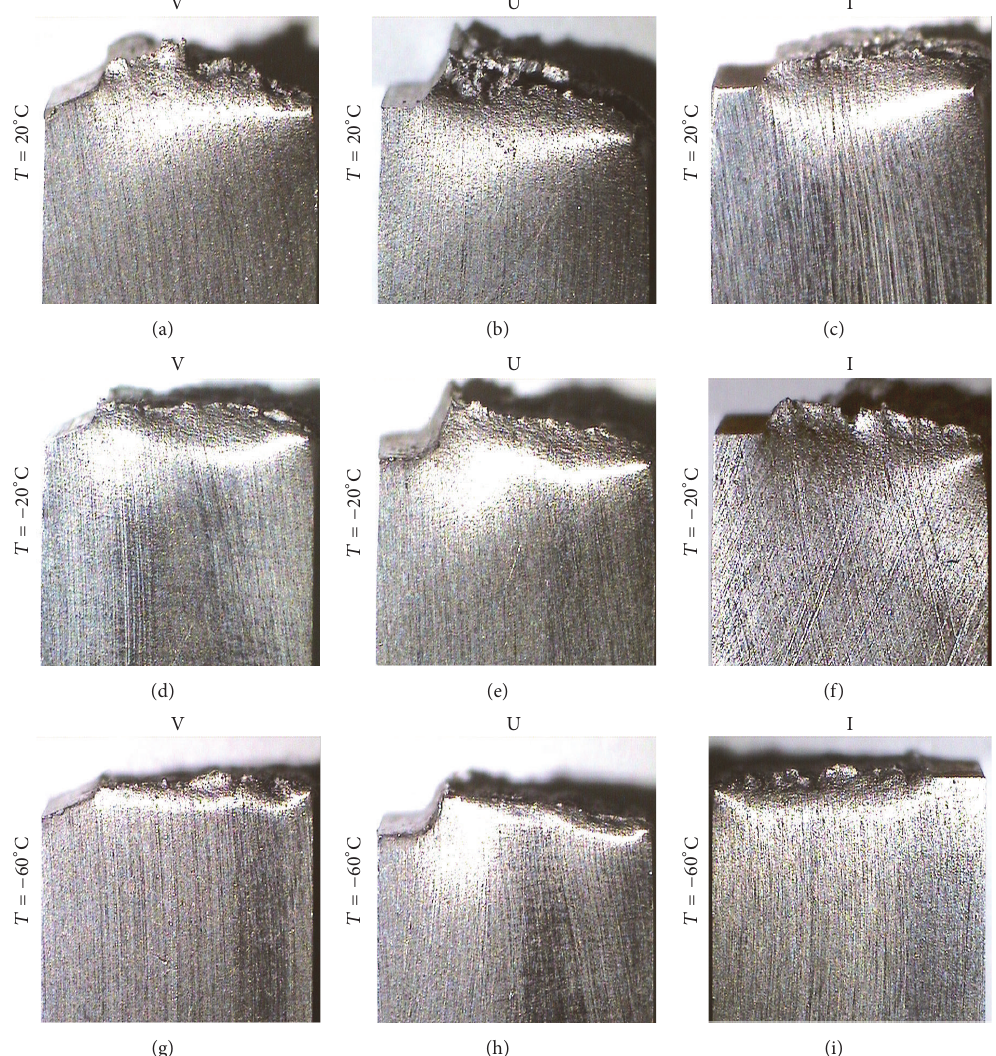
Figure 3: Optical images of the shear lips in specimens with V-notch (a), U-notch (b), and I-notch (c) for the test temperature T = 20 ∘ C.